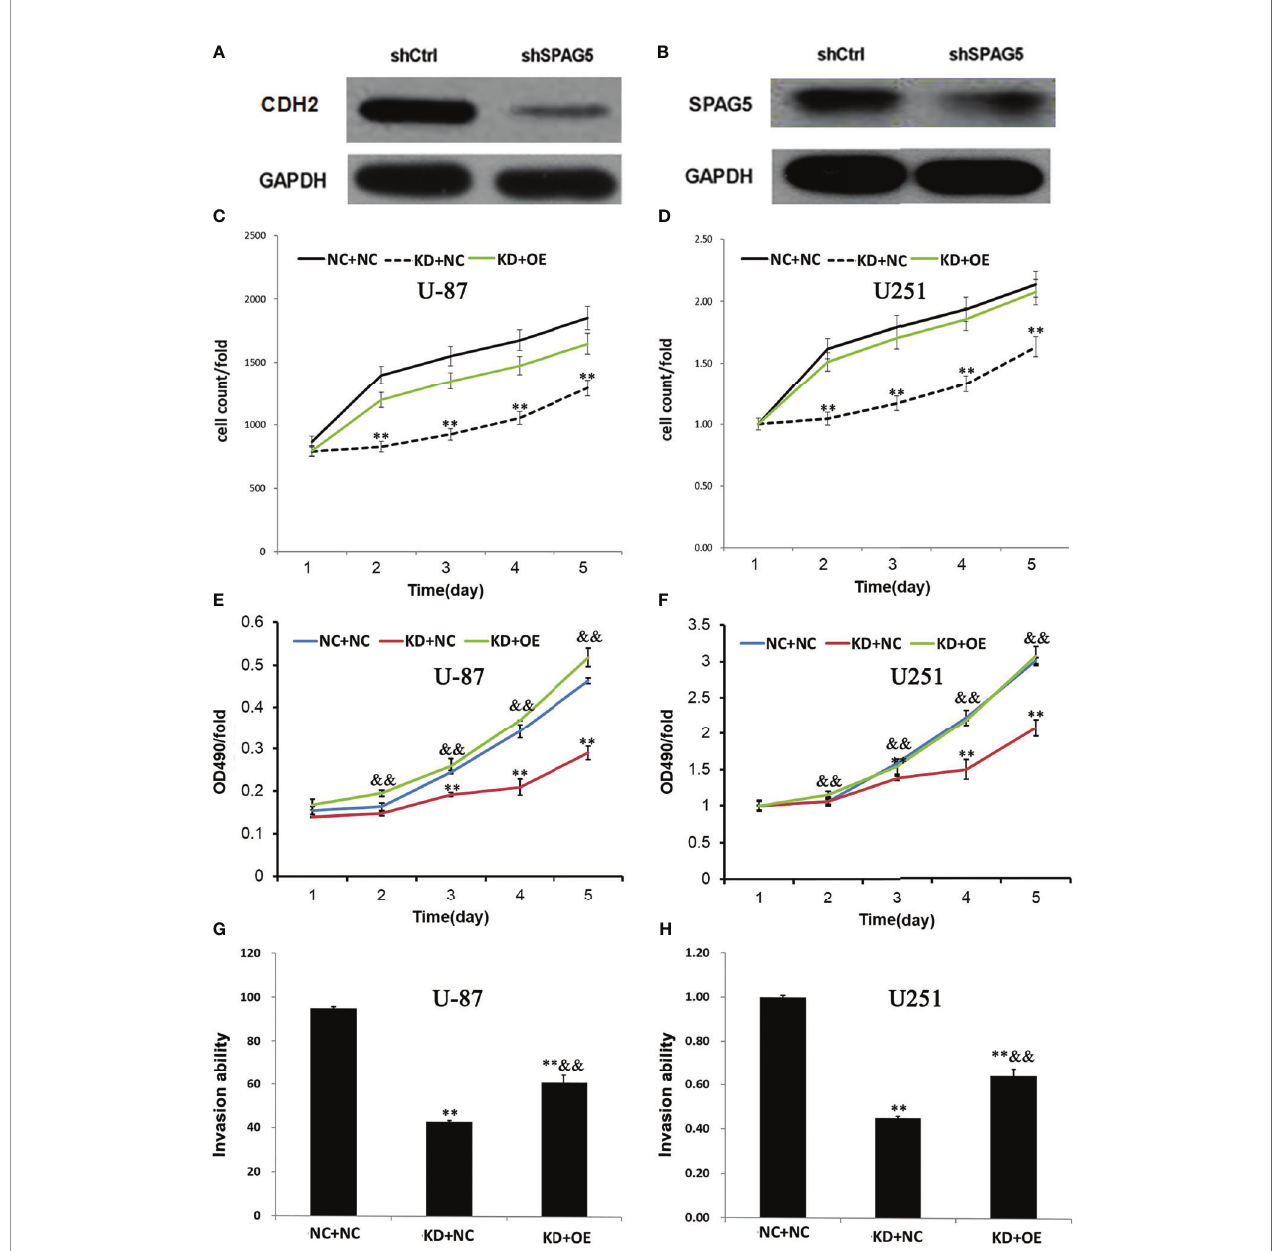
FIGURE 8 | SPAG5 knockdown decreased CDH2 expression in glioma cells. The expression of (A) CDH2 and (B) SPAG5 in cells transfected with SPAG5- shRNA were measured by western blotting. The HCS proliferation screening analysis of (C) U-87 cells and (D) U251 cells. ShRNA lentivirus-infected (E) U-87 and (F) U251 cells were cultured for 5 d and used in MTT assay. The absorption rate of light at wavelength of 490 nm was compared with time in each group. OD490 re fl ects the number of active cells. The invasion ability of transwell transferred (G) U-87 and (H) U251 cells in each experimental group was compared with that in the control group. NC+NC: Parental glioma cells+Vector; KD+NC: Parental glioma cells+Knockdown-SPAG5+Vector; KD+OE: Parental glioma cells +Knockdown-SPAG5+overexpression-CDH2. Results were expressed as mean ± SD from three independent experiments. vs NC+NC group, ** P < 0.01; vs KD +NC group, && P <